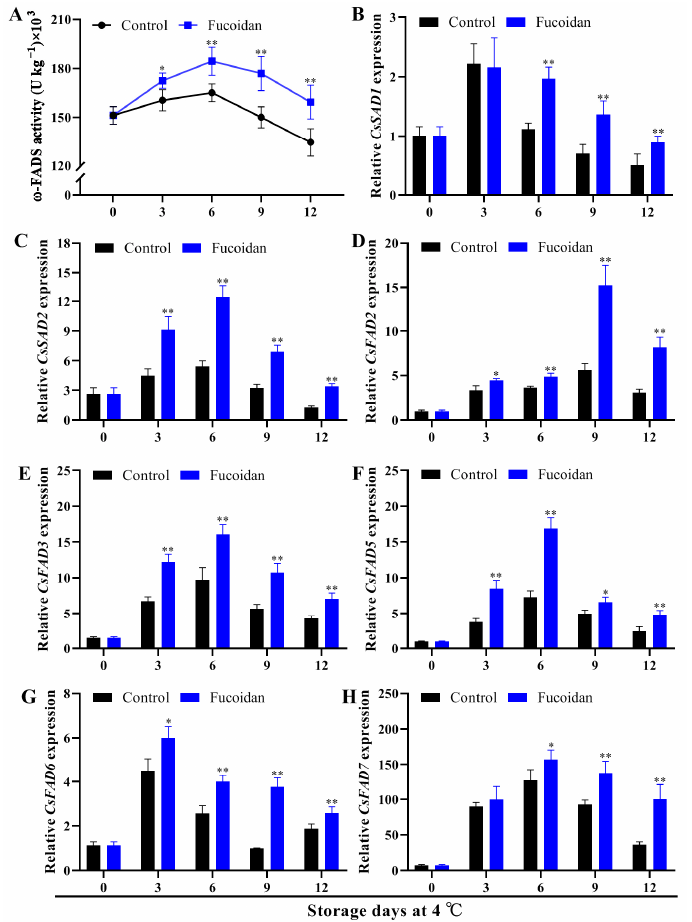
Figure 4. ω -FADS activity ( A ) and gene expression of CsSAD1 ( B ), CsSAD2 ( C ), CsFAD2 ( D ), CsFAD3 ( E ), CsFAD5 ( F ), CsFAD6 ( G ), and CsFAD7 ( H ) in fucoidan-treated and control cucumber fruit during storage at 4 °C. Values are marked as mean ± standard deviation (SD) of three replicates. Symbols * and ** express significant differences at p < 0.05 and p < 0.01 between fucoidan-treated and control fruit, respectively.